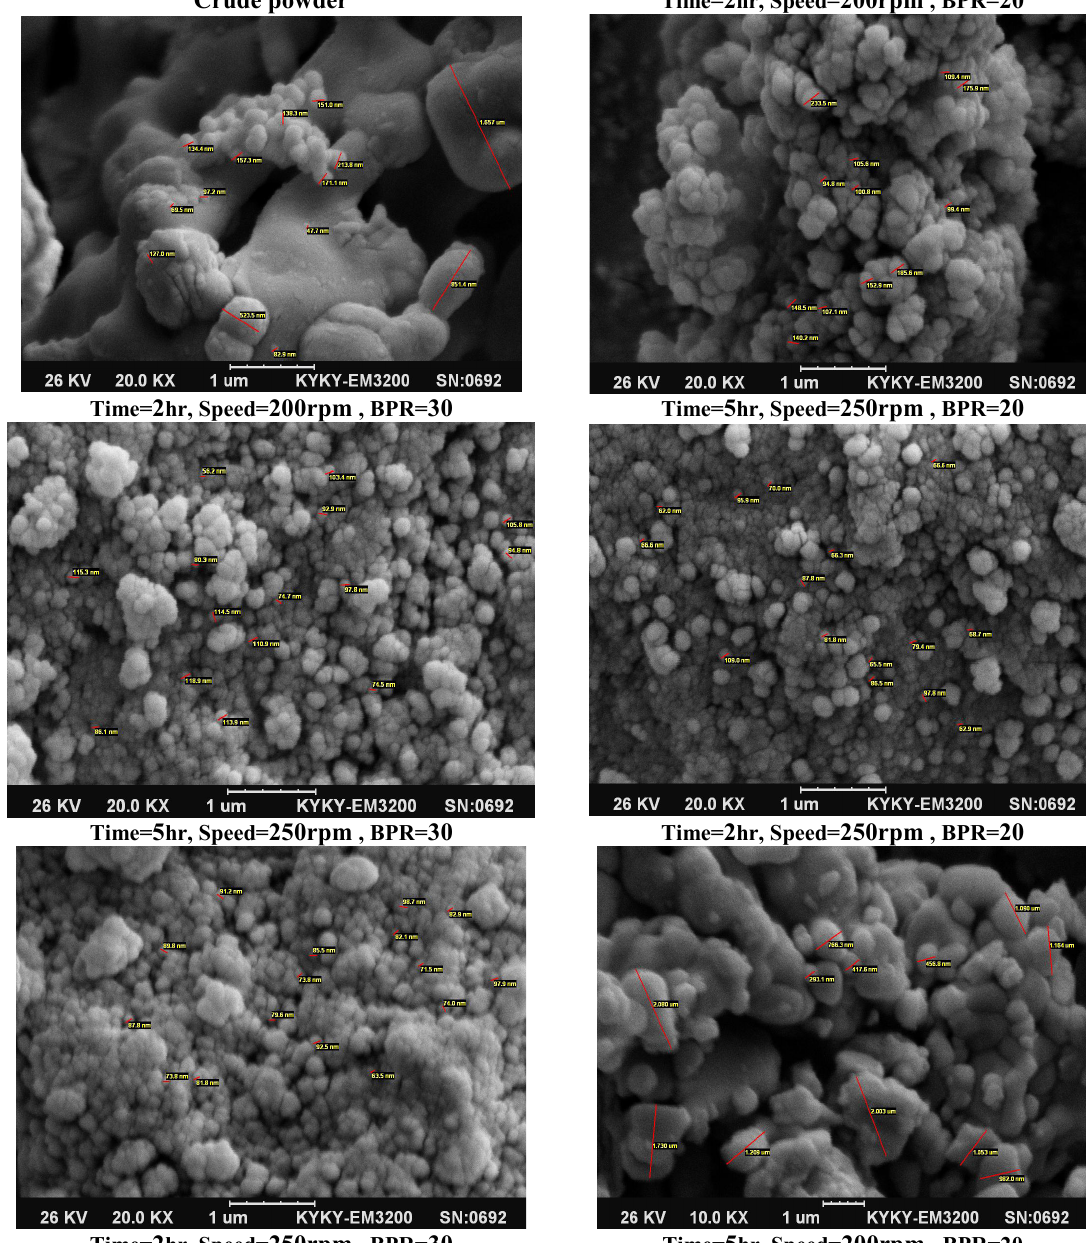
in various mechanical milling 2